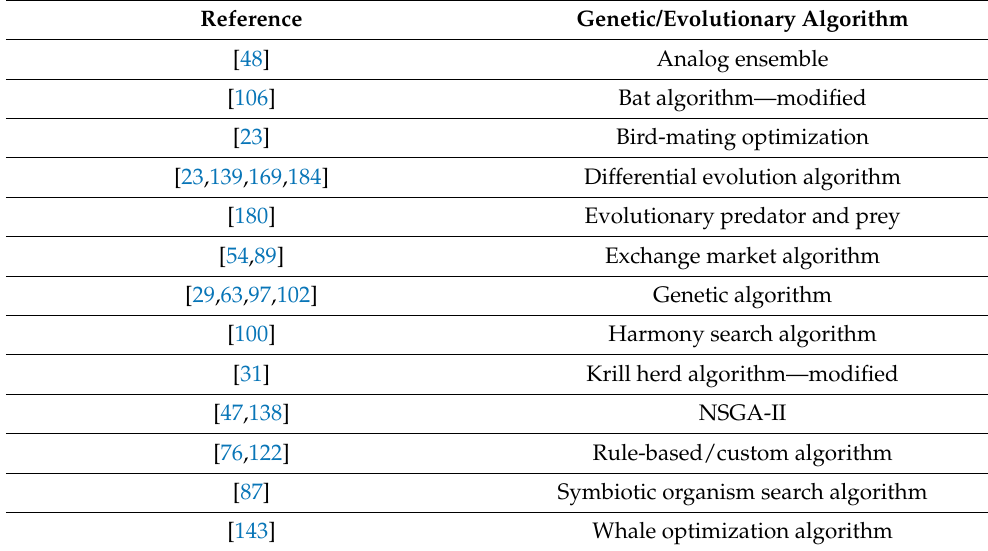
Table 10. Genetic or evolutionary metaheuristic algorithms employed in the DGS literature.